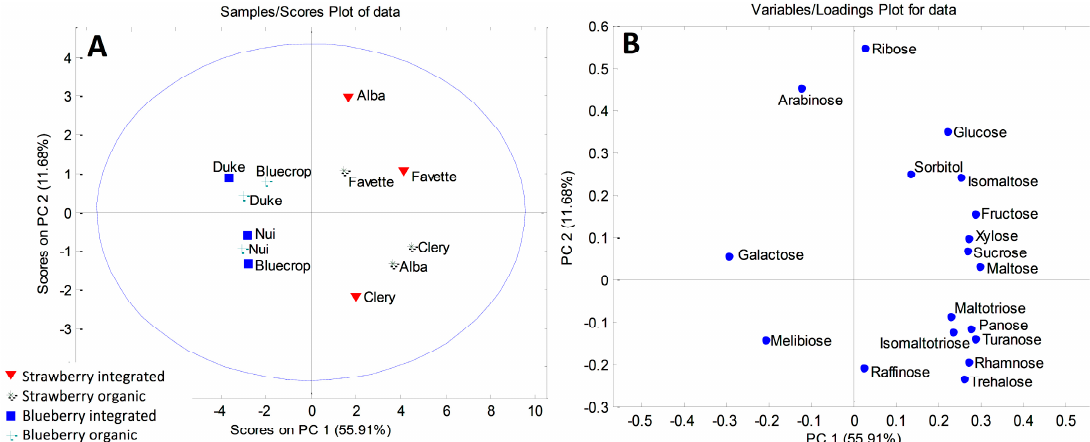
Figure 1. PCA model for sugar-based classification and differentiation of blueberry and strawberry fruits: ( A ) score plot; ( B ) loading plot.